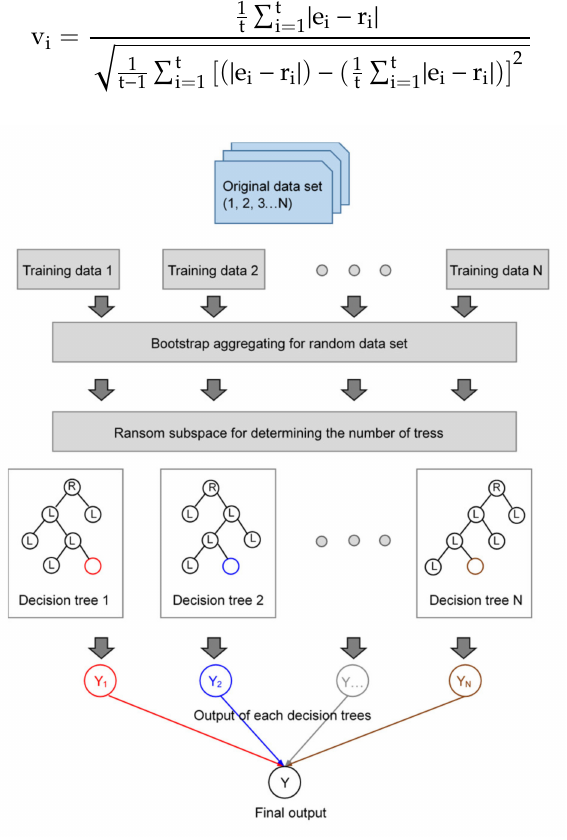
Figure 2. Architecture of random forest. The R and L in decision tress denote the root node and leaf node,